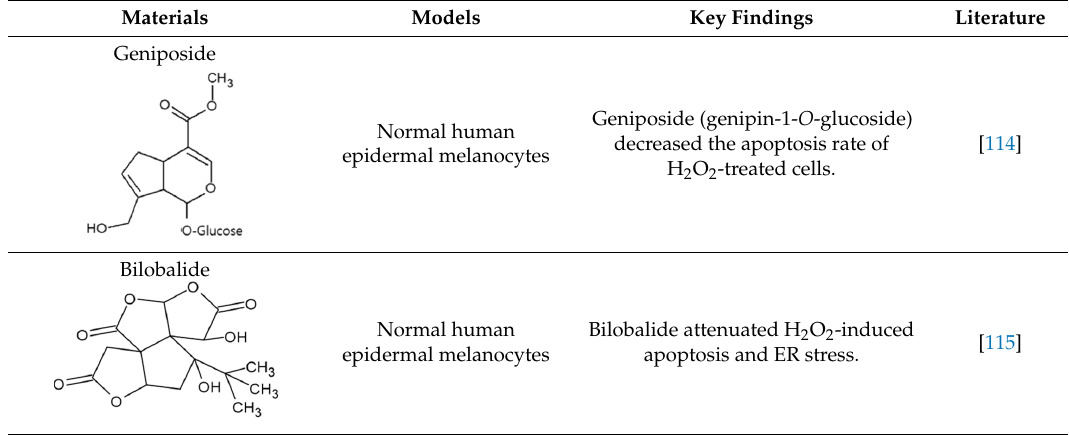
Table 2. Cytoprotective effects of plant-derived antioxidants in melanocytes.